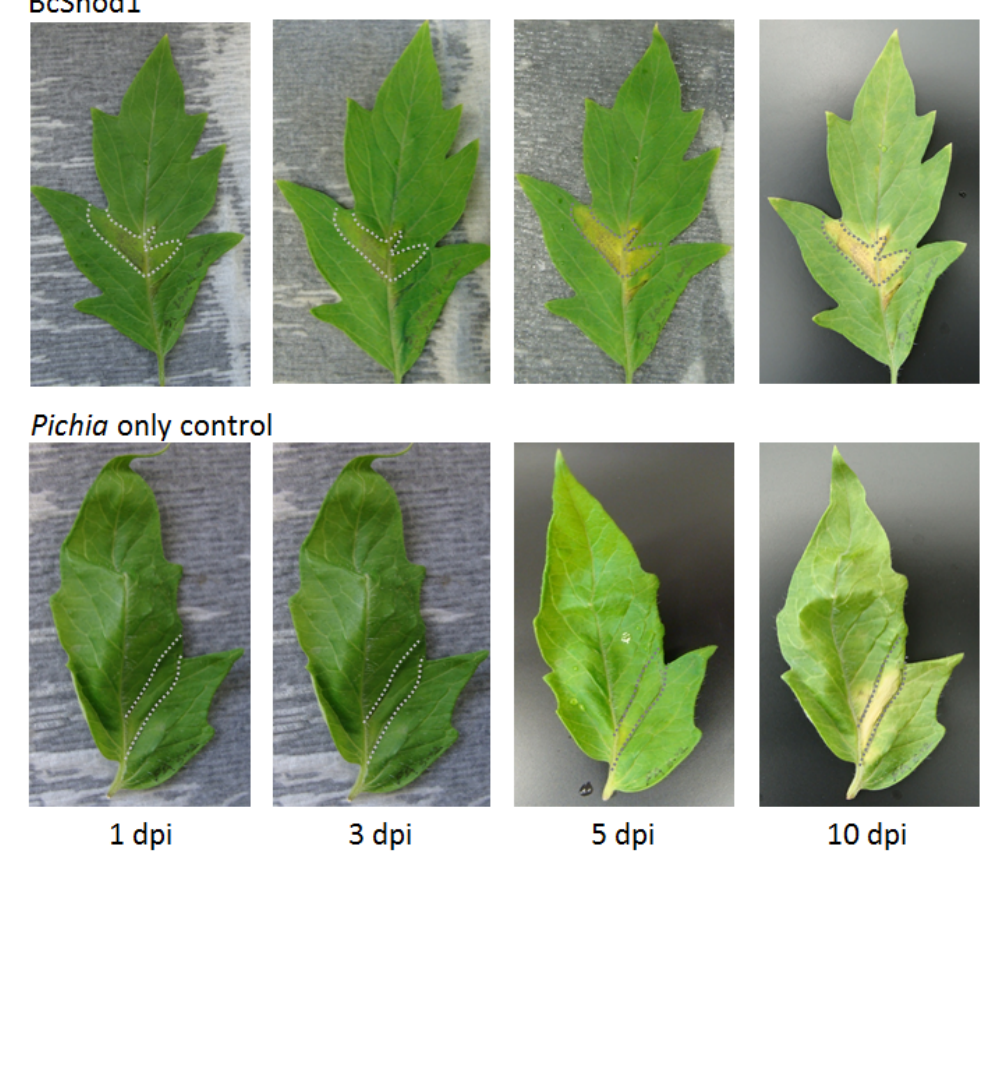
Figure 6. Detached tomato leaves were infiltrated with BcSnod1. One hundred and thirty micrograms of Pichia produced HPLC purified BcSnod1 was injected into detached tomato leaves. Discoloration in the area of injection was observed after 1 day. Discoloration increased with time and showed a maximum at 10 dpi. Necrosis was not observed presumably because the detached leaves are not viable after ~10 days. Infiltration with the vector only control (bottom row) showed minor discoloration after day 5, though no signs of spreading were observed. Dotted lines are for reference, showing the area of initial